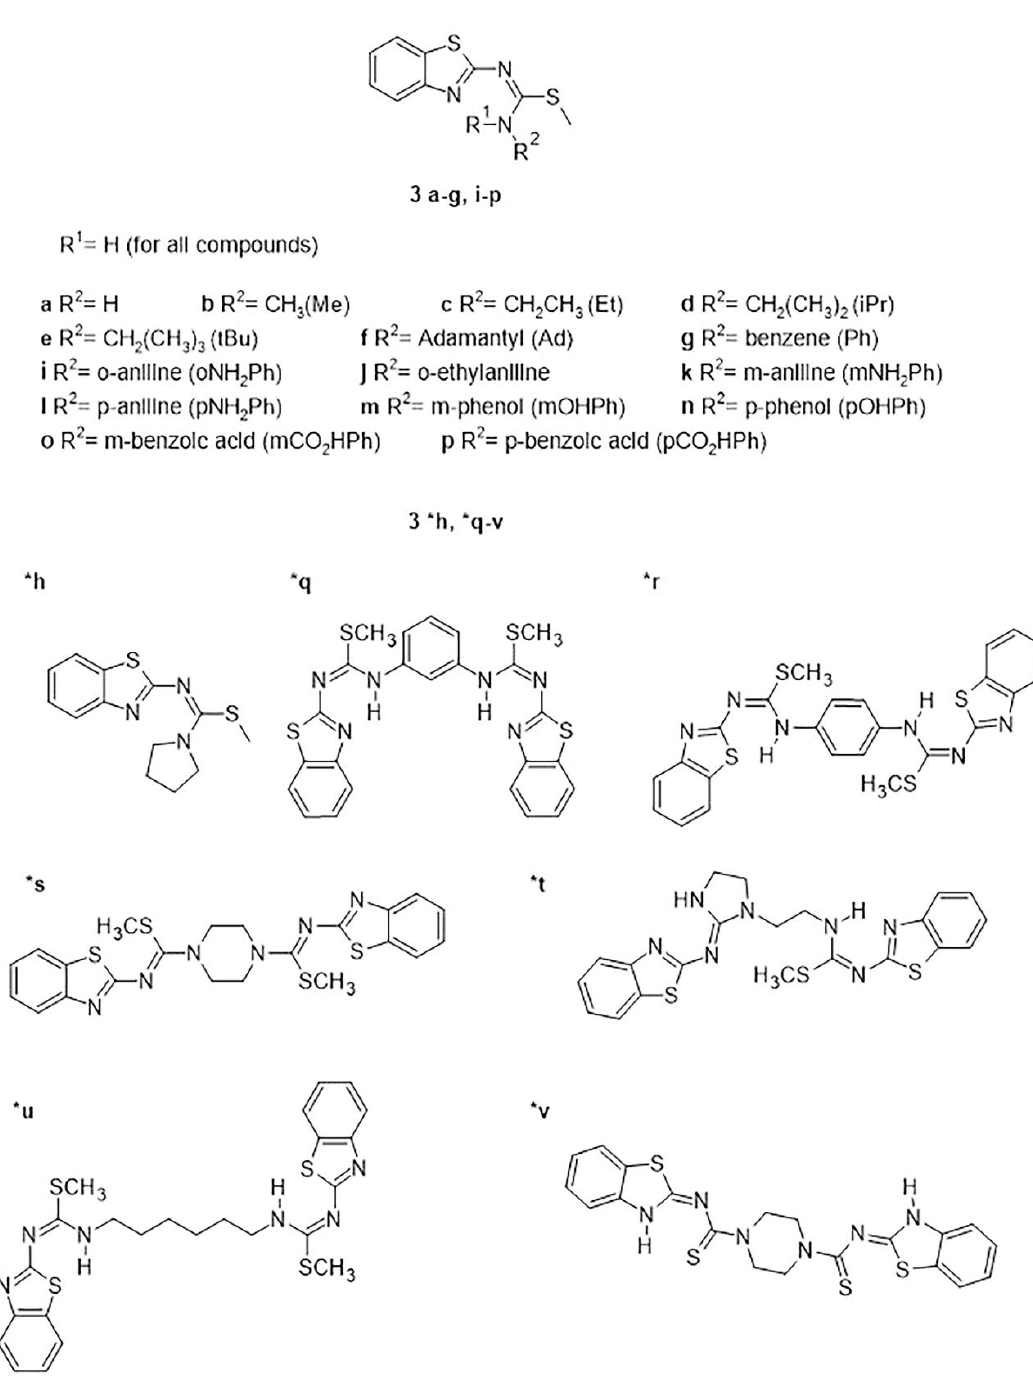
Figure 1. Chemical structure of the 22 benzothiazole-isothiourea derivatives. (*) Complete struc- tures.